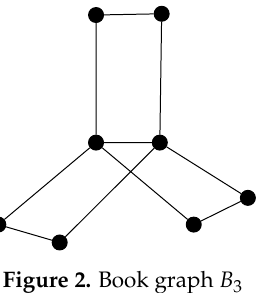
Figure 2. Book graph B 3